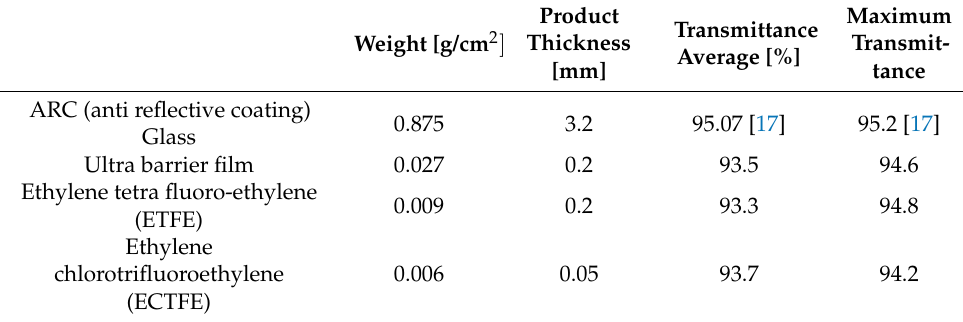
Table 1. Characteristics of front-surface